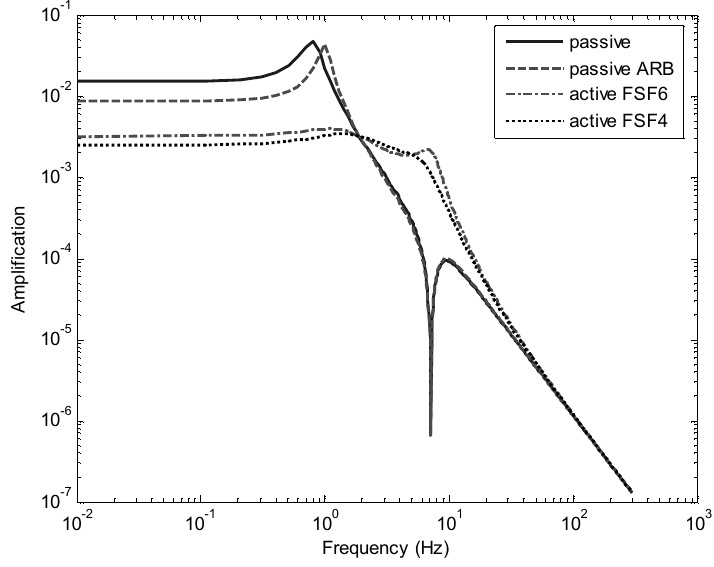
Fig. 12. Suspension deflection for lateral acceleration input.